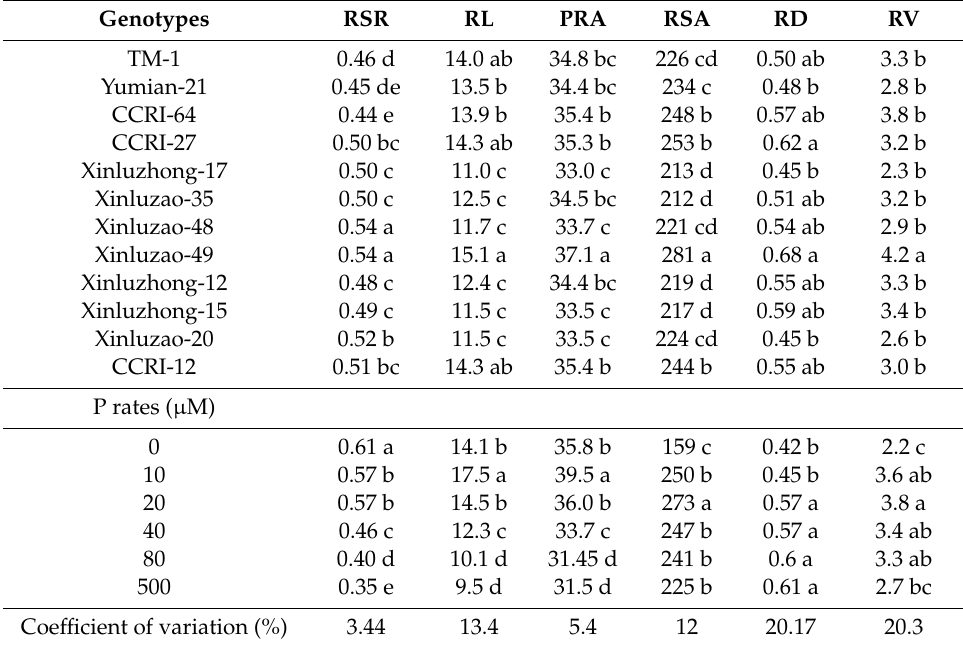
Table 2. Root shoot ratio (RSR), root length (RL, m), projected root area (PRA, cm 2 ), root surface area (RSA, cm 2 ), root diameter (RD, mm), and root volume (RV, cm 3 ) of 12 cotton genotypes grown at di ff erent P concentrations in hydroponic culture.